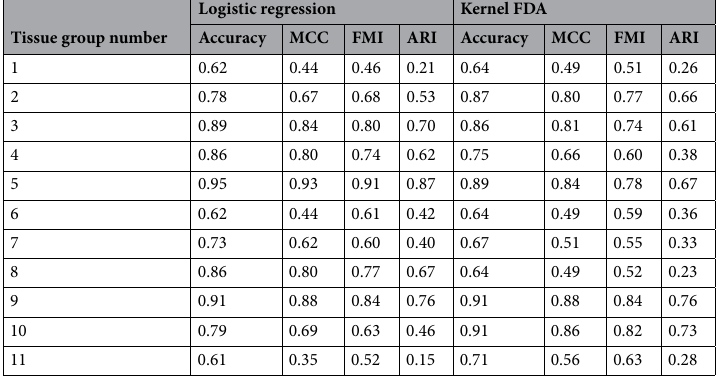
Table 4. Performance metrics for the multiclass classification of the burned porcine tissue and the synthetic tissue samples into the three loading rate classes.